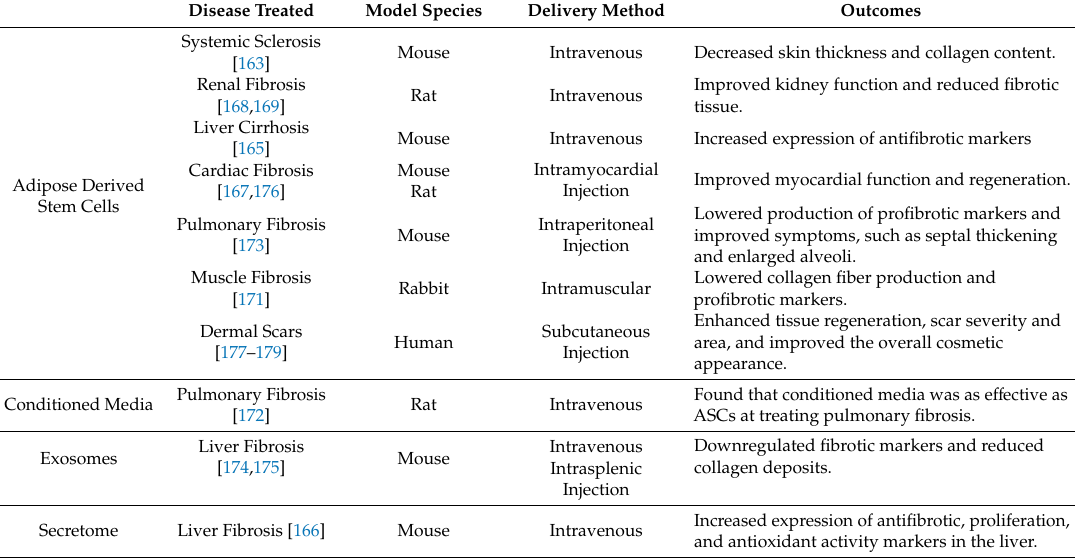
Table 2. Synopsis of research that used cells and vesicles sourced from adipose tissue to treat other fibrotic diseases.